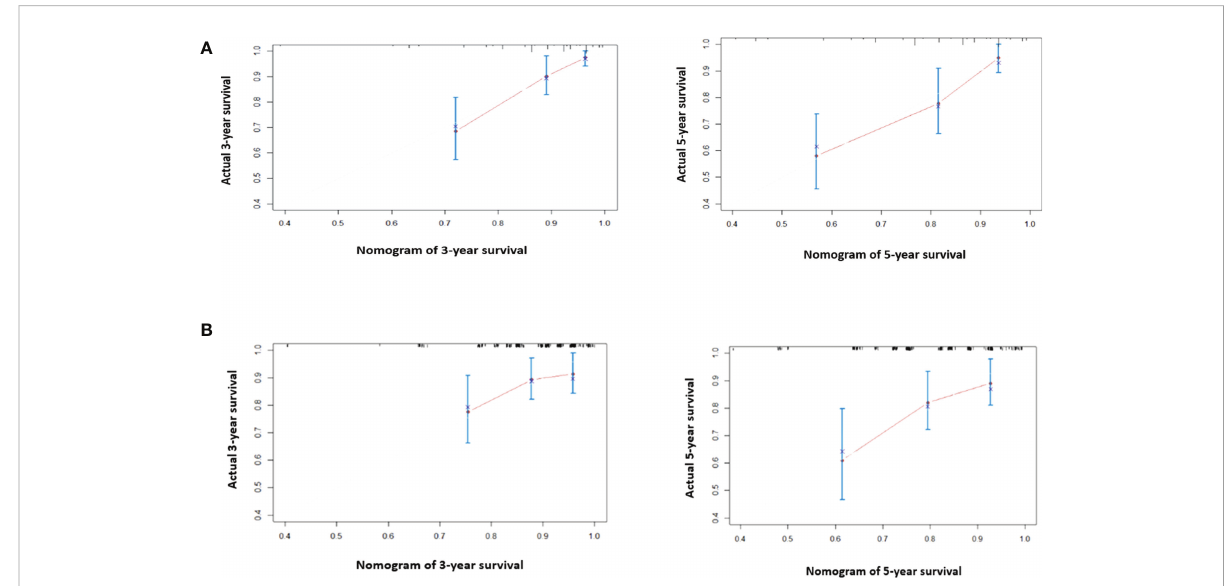
FIGURE 3 The calibration curve for predicting 3- and 5-year survival in the training cohort (A) and validation cohort (B) . Nomogram-predicted probability of overall survival is plotted on the x -axis; true overall survival is plotted on the y -axis. The predicted probability is almost the same as the true probability. The prediction error of the model is acceptable.